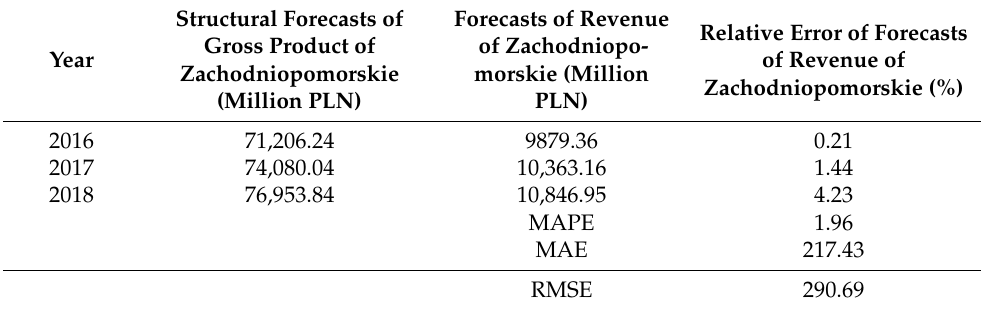
Table 8. Forecasts of gross product, revenue and their relative errors for Zachodniopomorskie (based on model 9, forecasts of GDP—linear trend and structural forecasts of the regional gross product of